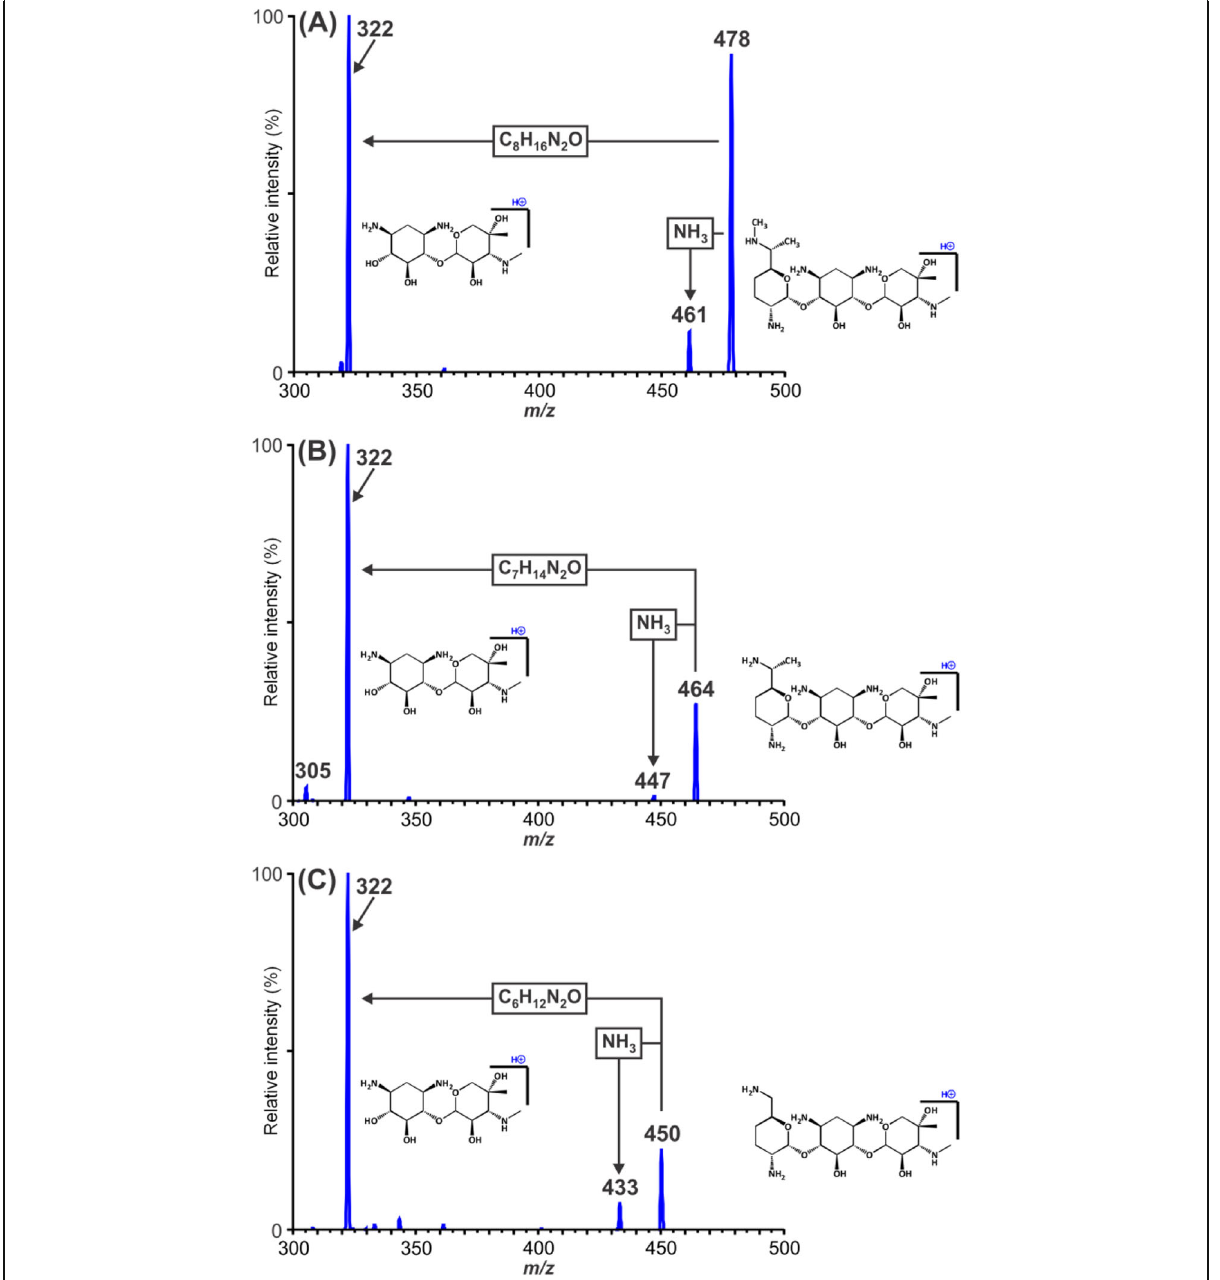
Fig. 3 Product-ion spectra of m/z 478 ( a ), m/z 464 ( b ), and m/z 450 ( c ) acquired from ions generated from a solution of